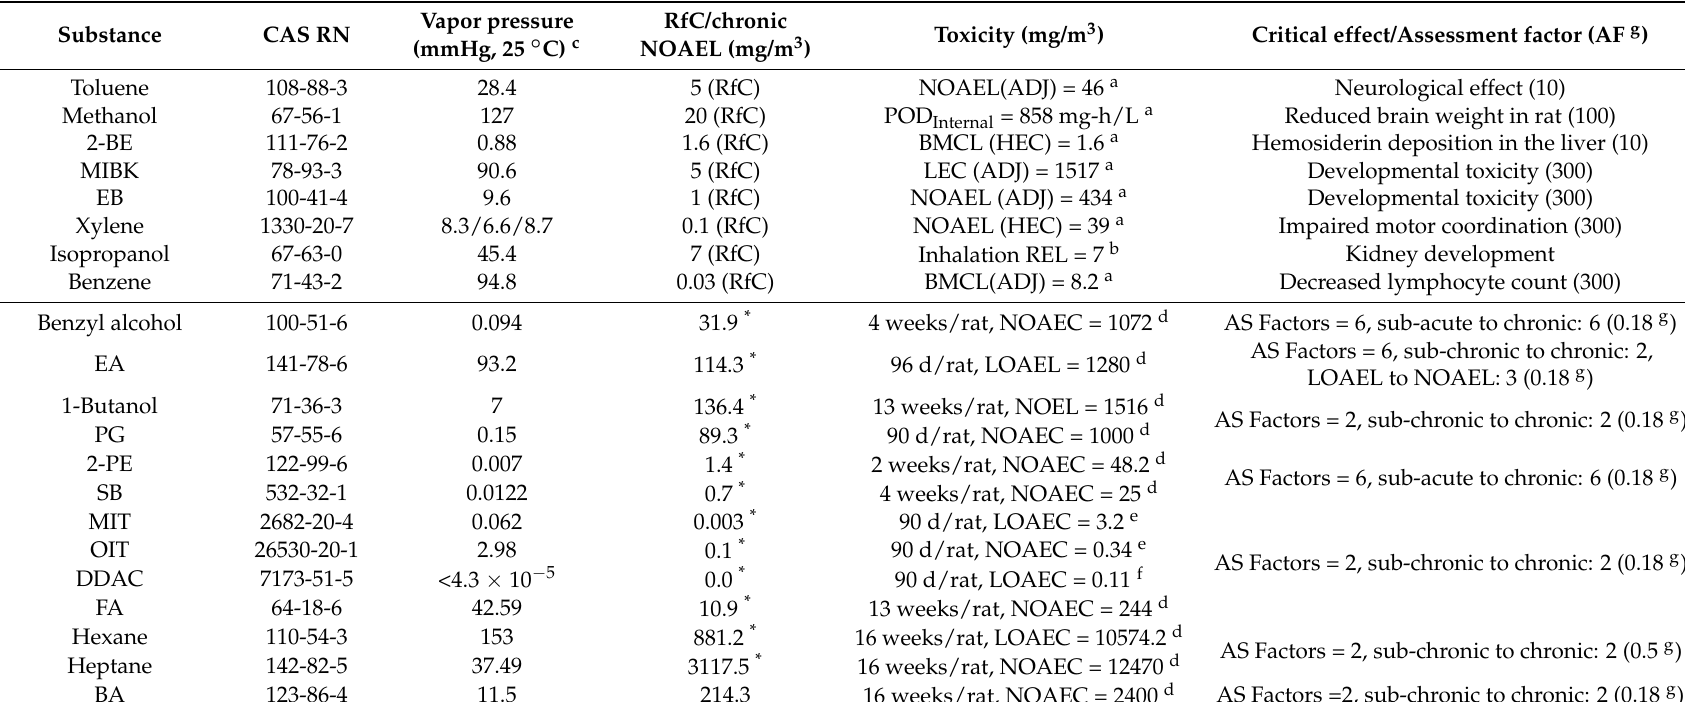
Table 3. Toxicity information of studied substances in